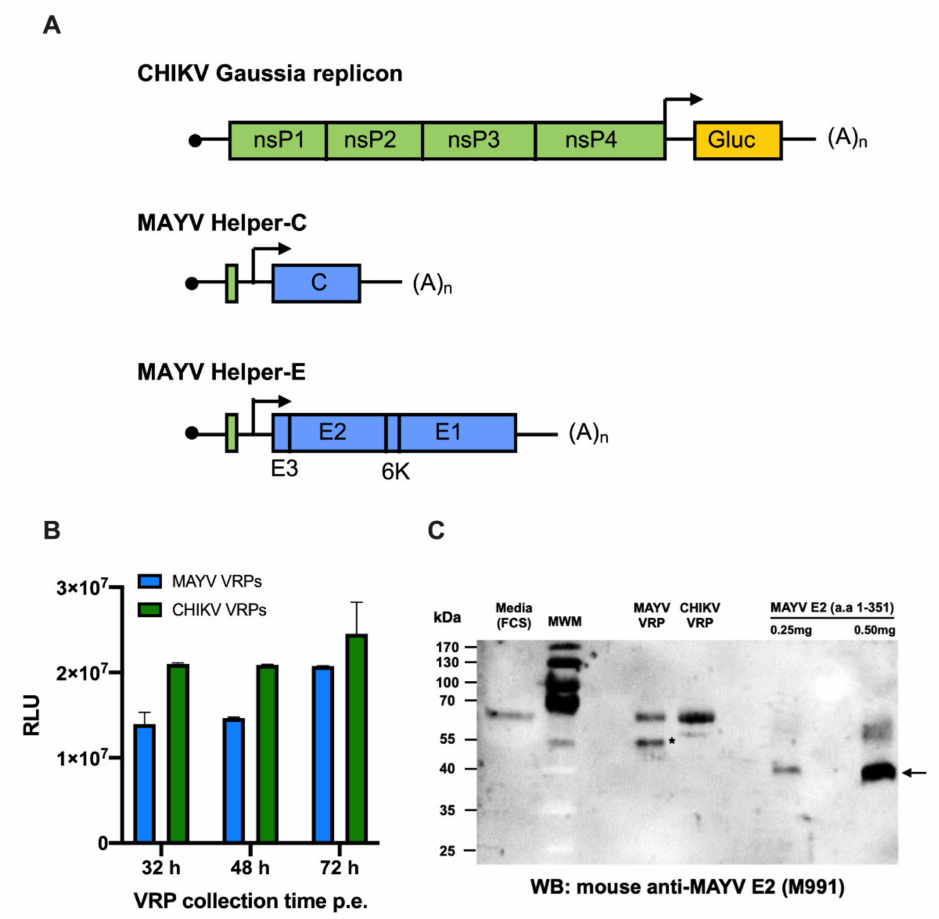
Figure 5. MAYV VRP system. ( A ) Schematic representation of the CHIKV replicon expressing Gluc marker and the MAYV helper-C and MAYV helper-E RNAs. Lines represent non-translated